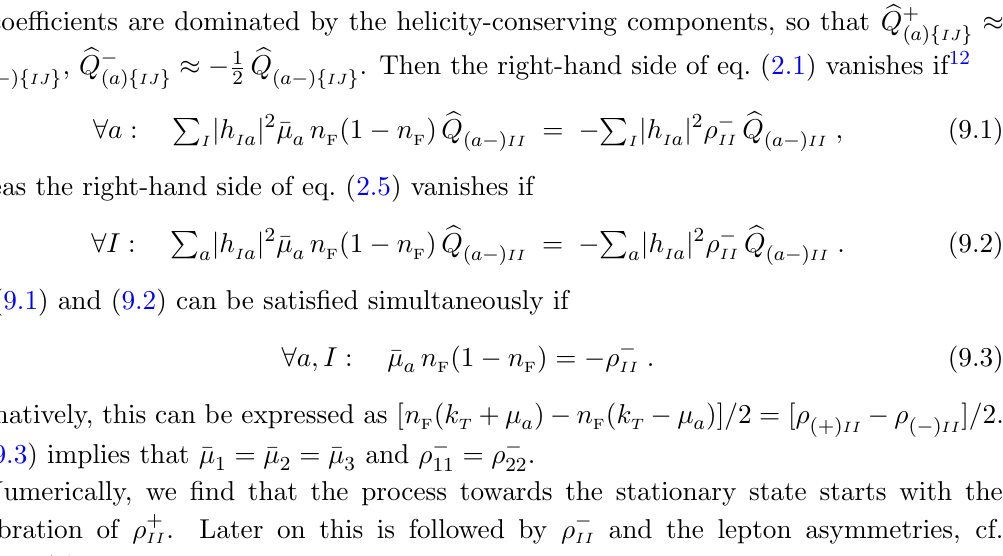
(cid:24) T at T (cid:24) 100 GeV. Right: an illustration of the equilibration of T